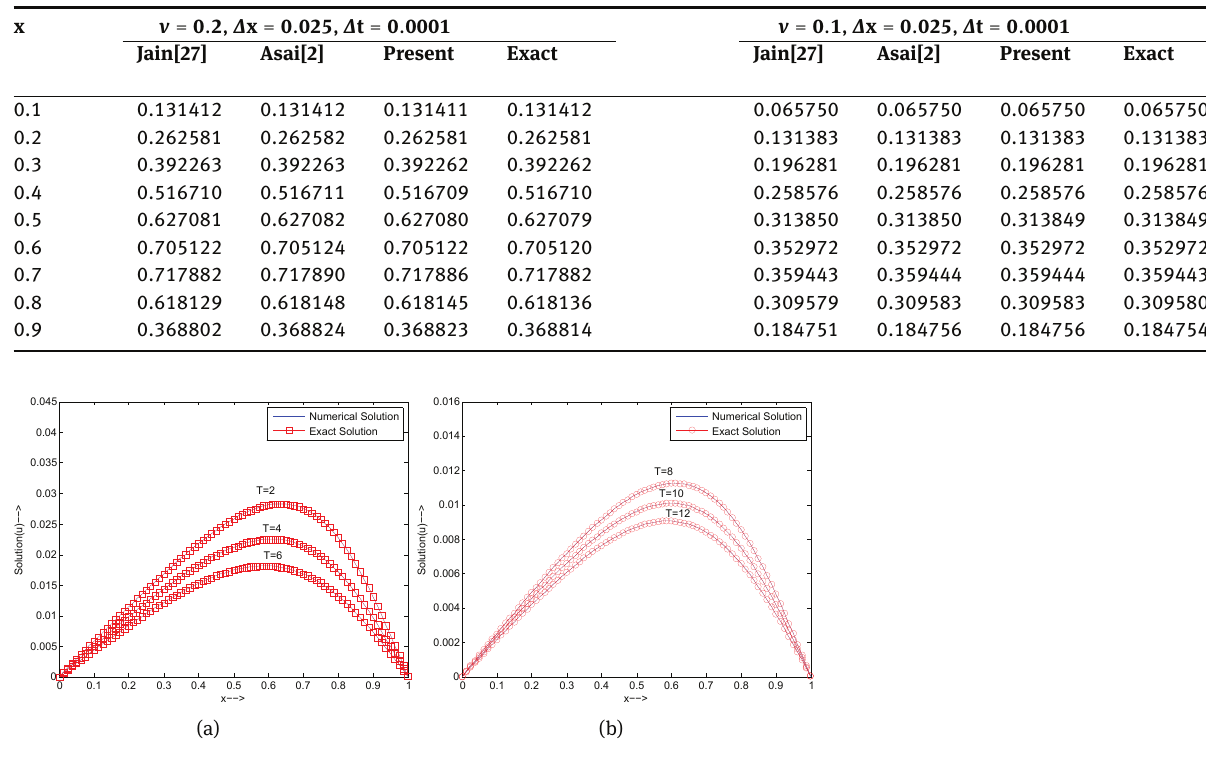
Fig. 11: Numerical solutions of Example 3 at different times for Δx = 0.0125 and different values of ν and Δt , (a) ν = 0.01 , Δt = 0.0001 (b) ν = 0.005 , Δt = 0.001 .